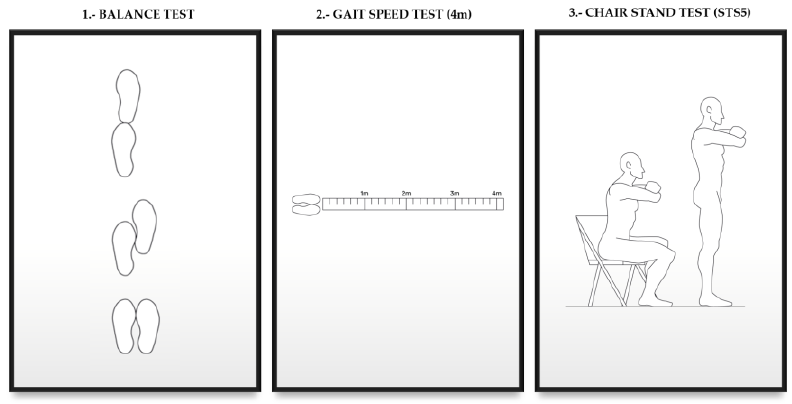
Figure 1. SPPB test.